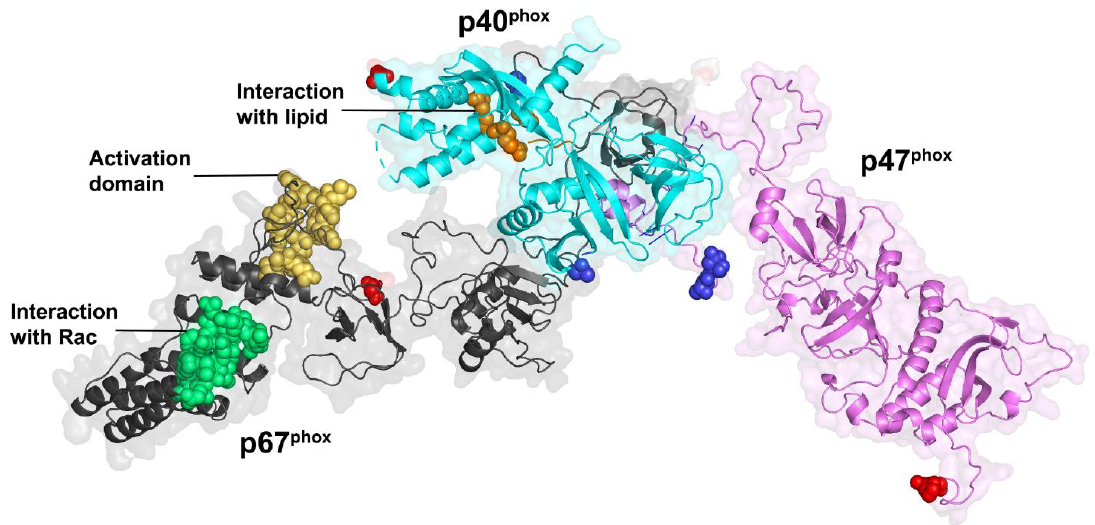
Figure 7. Model of the trimeric cytosolic complex of NADPH oxidase in the resting state [121]. Three-dimensional model of the heterotrimer: p40 phox (cyan ribbons), p47 phox (light purple ribbons), p67 phox (gray ribbons). The N-ter extremities are shown in red and the C-ter ends in blue. In p67 phox , green spheres represent the β hairpin of the Rac interaction (residues within 115–130), yellow spheres the activation domain (residues within 199–210 [122]). The residues of the lipid interacting PX domains in p40 phox are represented by the orange spheres (R58, K92 and R105 [51]). Figure inspired by [121].